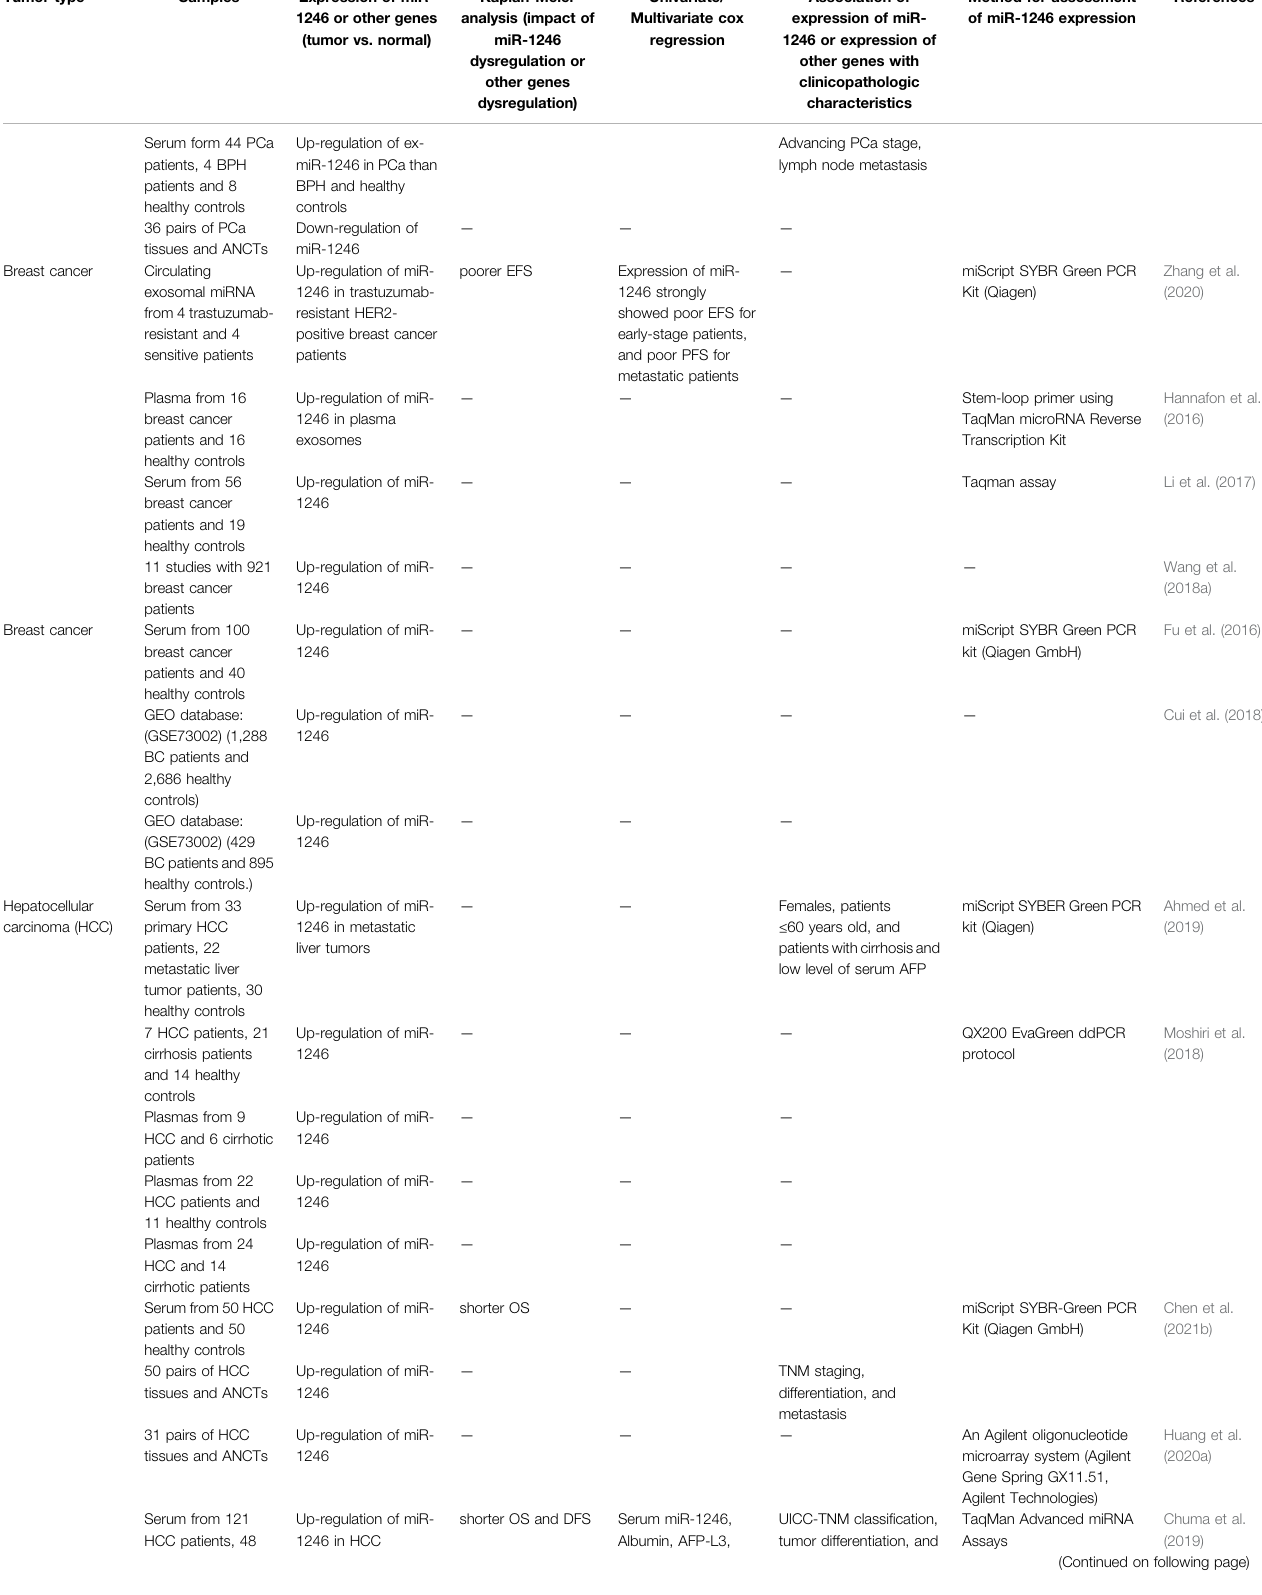
Breast cancer Circulating Breast cancer Serum from 100 Hepatocellular carcinoma (HCC)